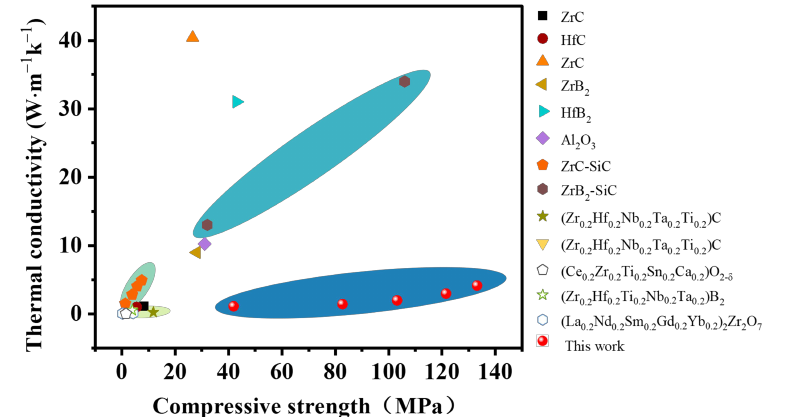
Figure 9. Comparison of the compressive strength and thermal conductivity of the obtained porous HECs with other porous UHTCs from previous reports